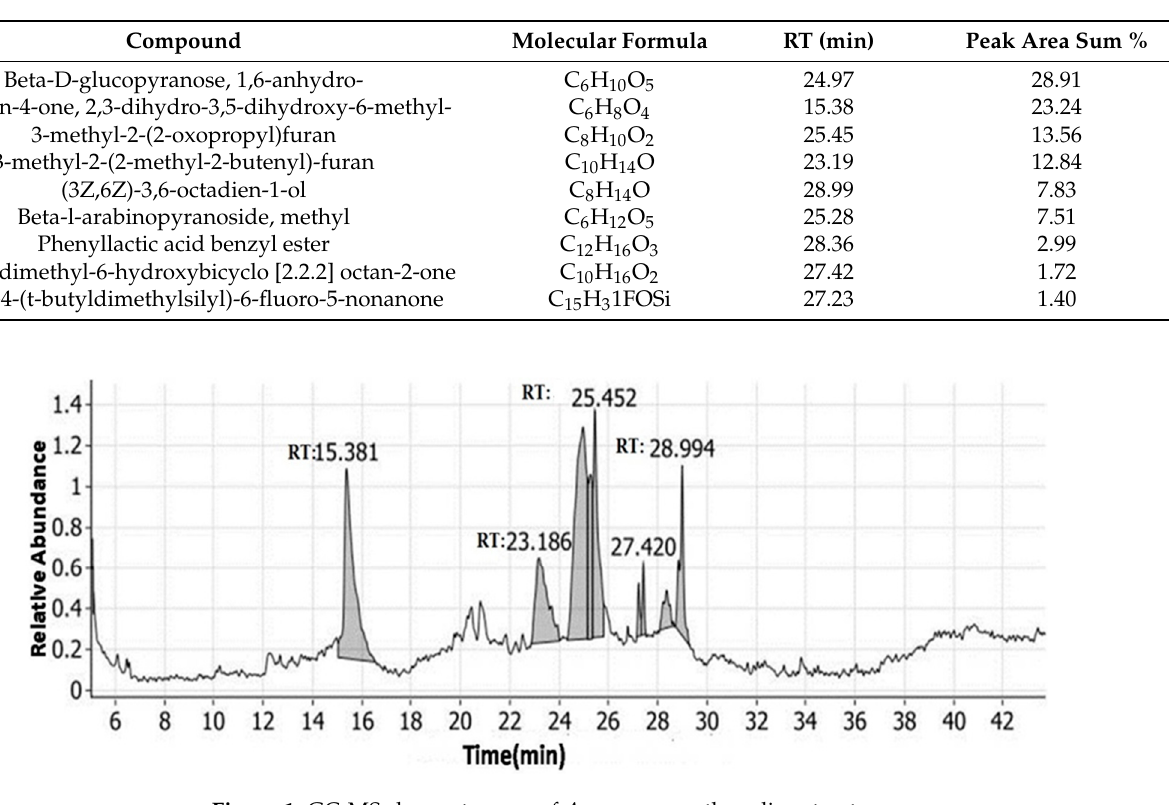
Table 2. Retention time and peak area sum (%) of the various compounds present in A. maurorum ethanolic extract analyzed by GC-MS.